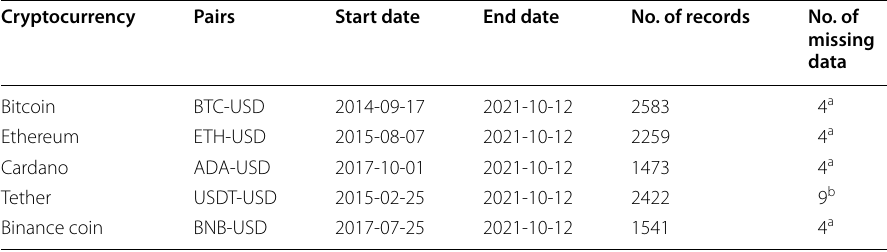
Table 1 Data characteristics